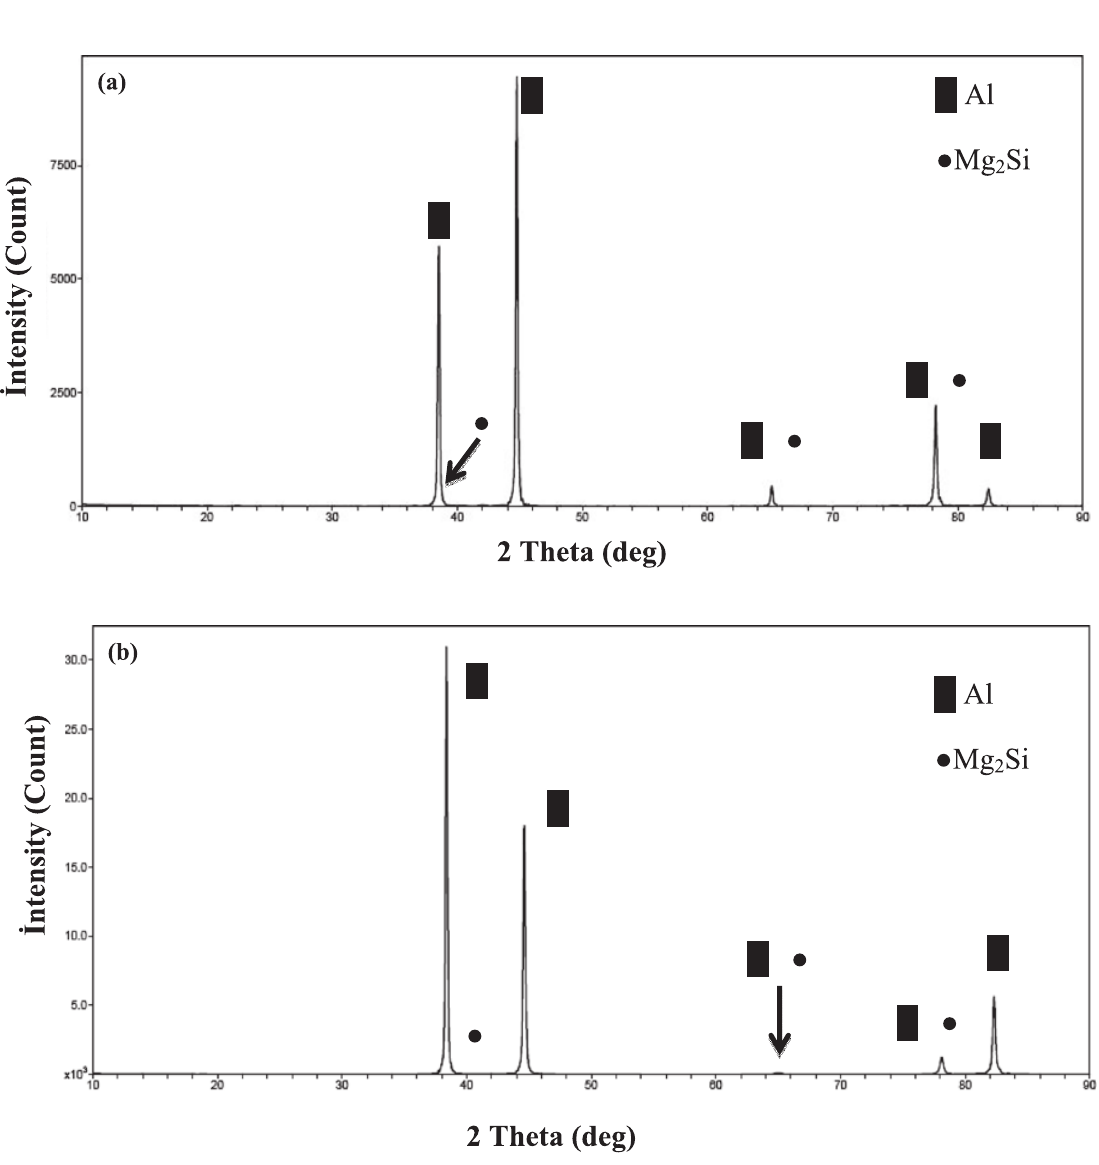
Fig. 2: XRD results of the alloy T5 (a) and T6 (b) heat